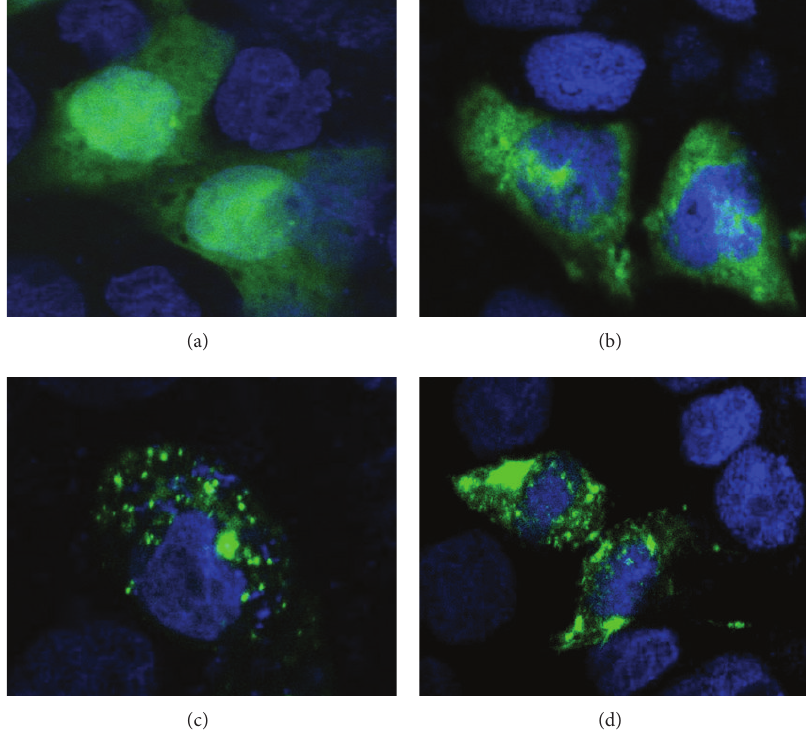
Figure 1: Localization of wild and mutated Wisp3 protein in C20/A4 cells by confocal microscope. Recombined plasmids WT- Wisp3 /pEGFP- C2, MUT 1000 T / C /pEGFP-C2, and MUT 840 delT /pEGFP-C2 were transfected transiently into human chondrocyte cell line C20/A4, and pEGFP- C2 vector was used as a control. The cells were observed using a confocal laser scanning microscope after 48 hours of transfection at magnification 1000x. (a) EGFP; (b) WT- Wisp3 ; (c) MUT 1000 T / C ; (d) MUT 840 delT ; Green fluorescence indicate the Wisp3 EGFP fusion protein. Blue fluorescence shows cell nuclei dye by DAPI. Note the distribution of WT- Wisp3 in cytoplasm and cell membrane uniformly. In contrast, the majority of MUT 1000 T / C and MUT 840 delT were aggregated to speckles or agglomerates in